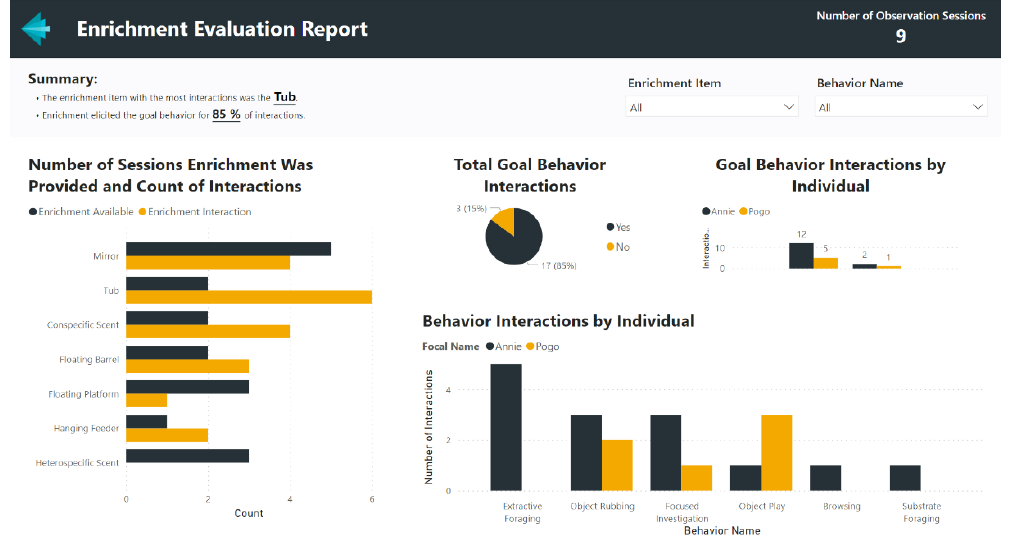
Figure 6. An example screenshot of an enrichment evaluation report created in Power BI using data from the ZooMonitor behavior recording app (the report template is available for download, see Supplementary Materials File S2).